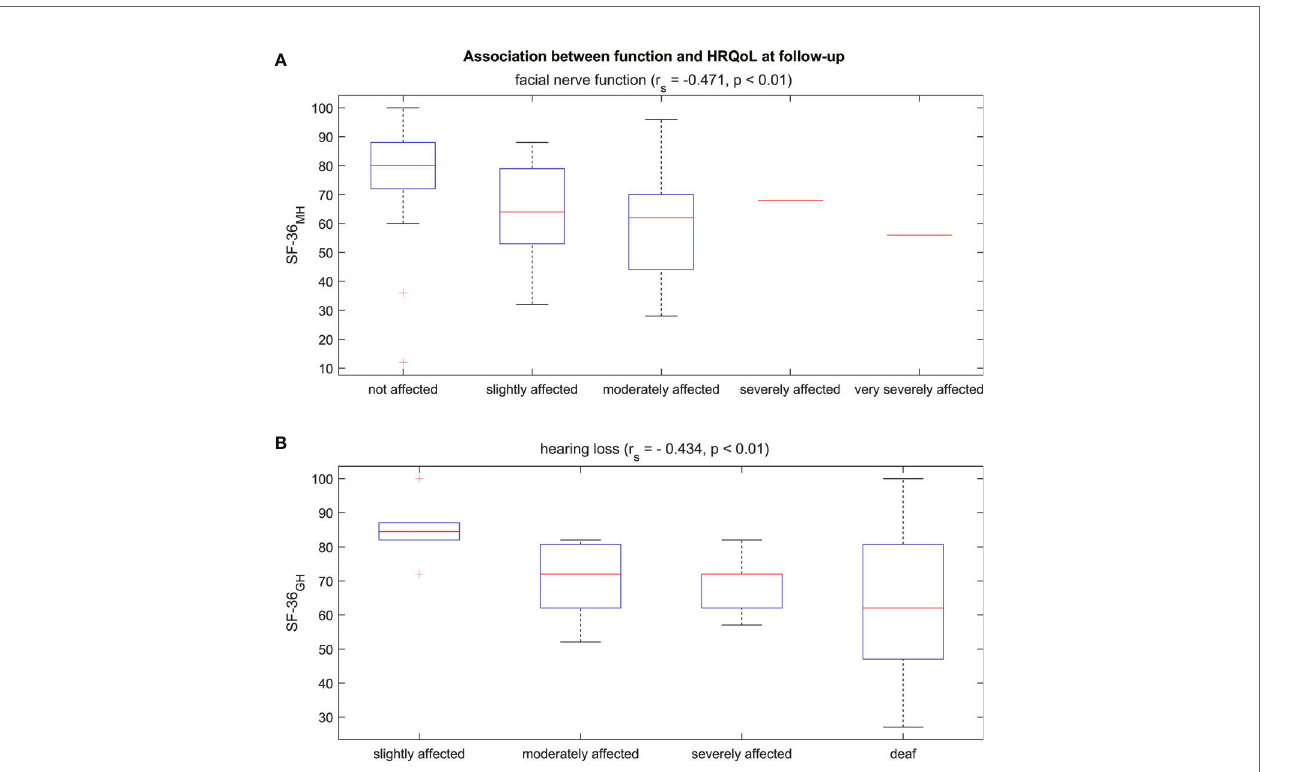
FIGURE 3 | Boxplots of the SF-36 scores of two selective domains that reached a signi fi cant correlation at follow-up with facial nerve function (A) and hearing loss (B)